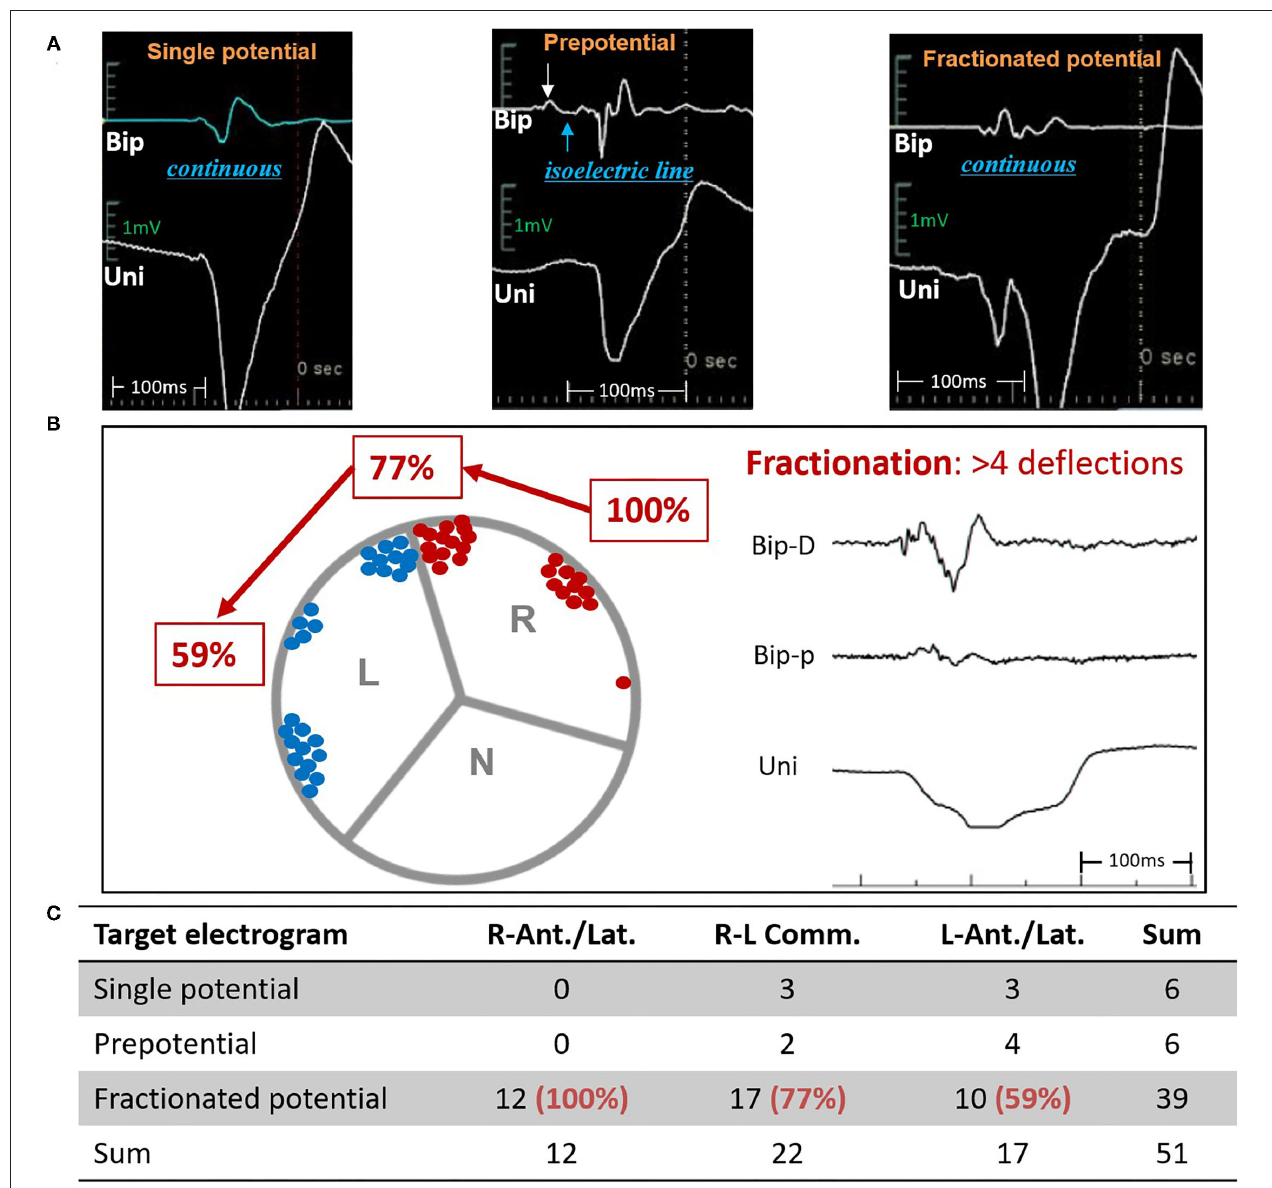
FIGURE 4 | Distributions and characteristics of the target bipolar electrogram. (A) 3 types of target electrograms. (B) Distributions and (C) proportions of fractionated potentials. Bip, bipolar electrogram; Uni, unipolar electrogram; ASV, aortic sinus of Valsalva; N, non-coronary ASV; L, left ASV; R, right ASV; R-Ant./Lat., right-lateral/anterior ASV; R-L Comm., left-right commissure; L-Ant./Lat., left-lateral/anterior ASV.